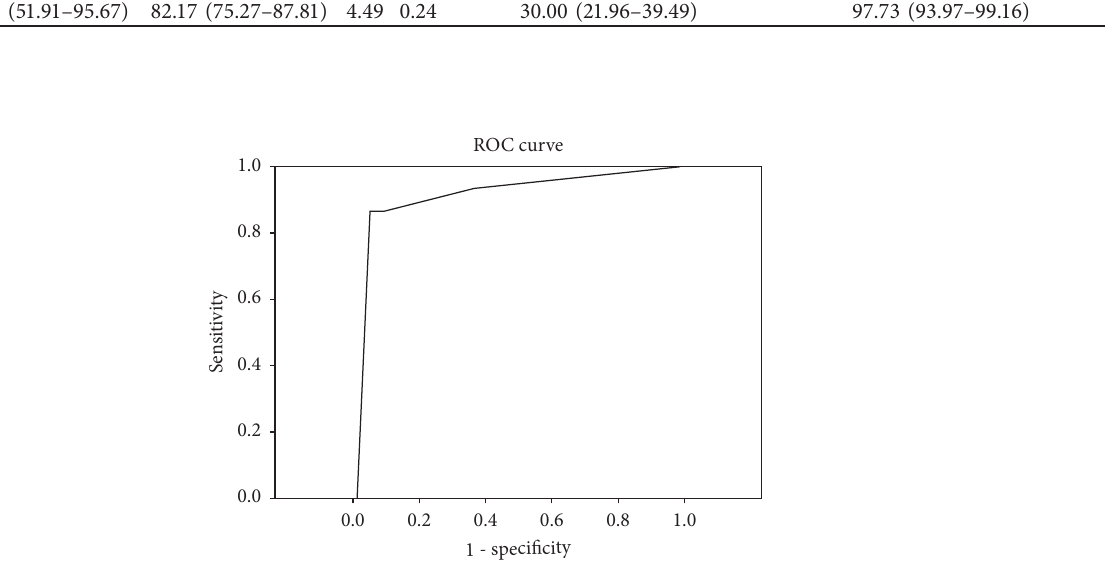
Figure 2: Receiver operating characteristic (ROC) curve analysis for ASA physical scores.